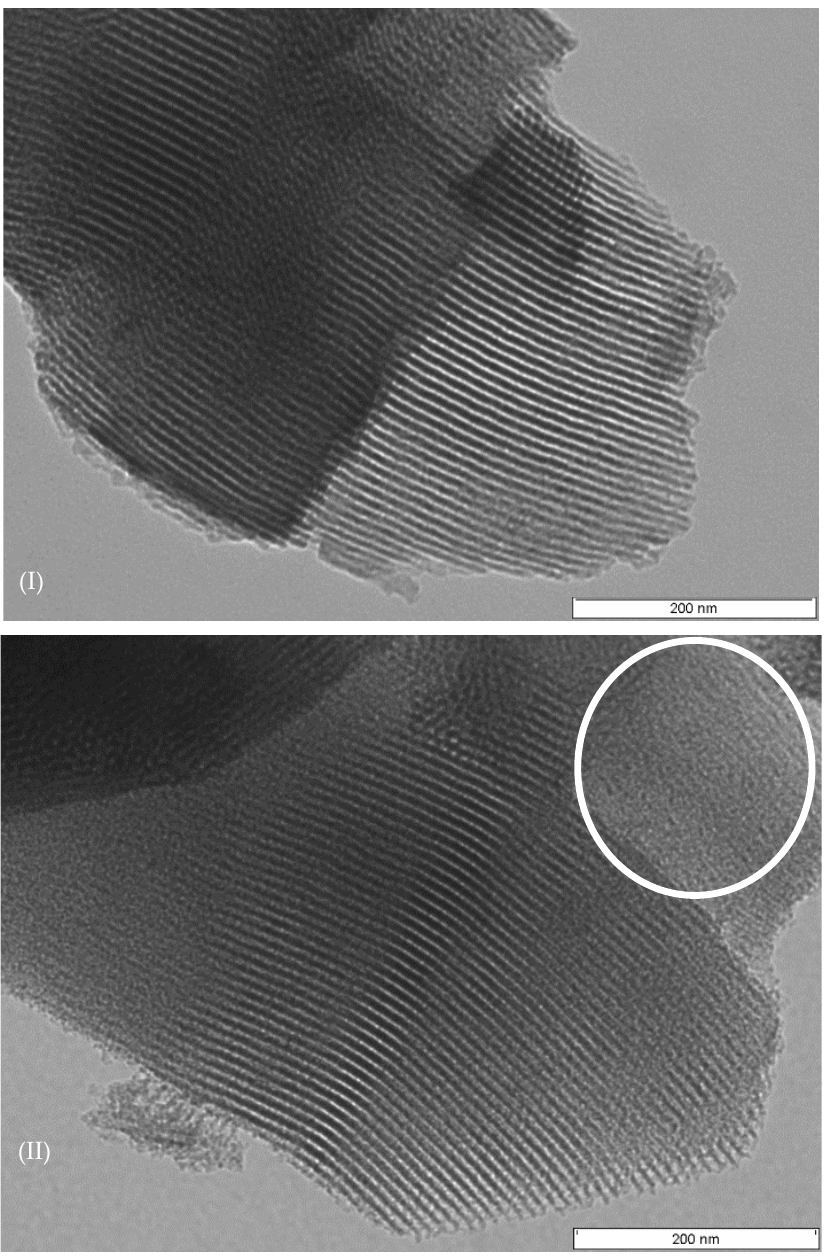
Figure 4. TEM photos: ( I ) KIT-6; ( II ) PW4-K-6.